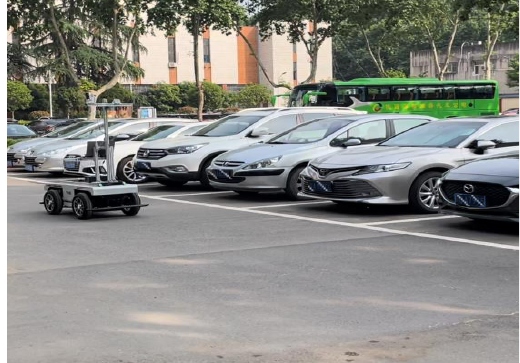
Figure 14. Camera image of the experimental scene.